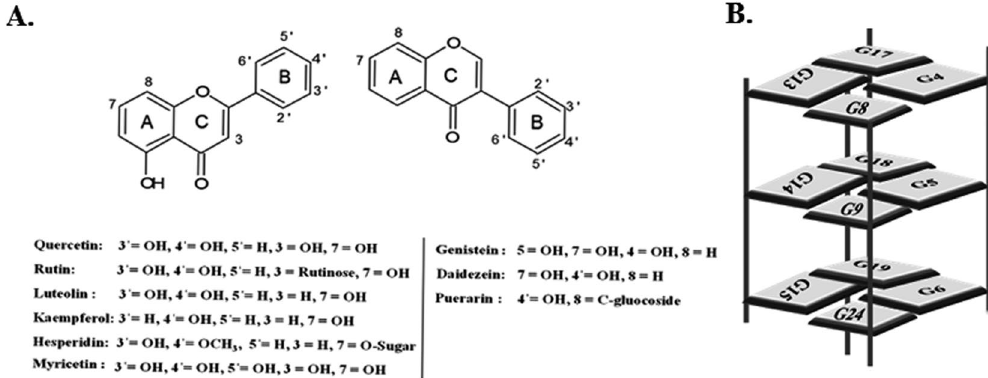
Figure 1. ( A ) Structure of flavonoids. Flavones, flavonols, flavanones (left side) and isoflavanols (Right side). Ring A-benzoyl system, Ring B- cinnamoyl system. ( B ) Schematic representation showing all G-tetrads involved in formingPu24T G-quadruplex DNA